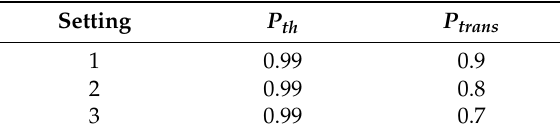
Table 6. Parameter settings with Num slot as variable.